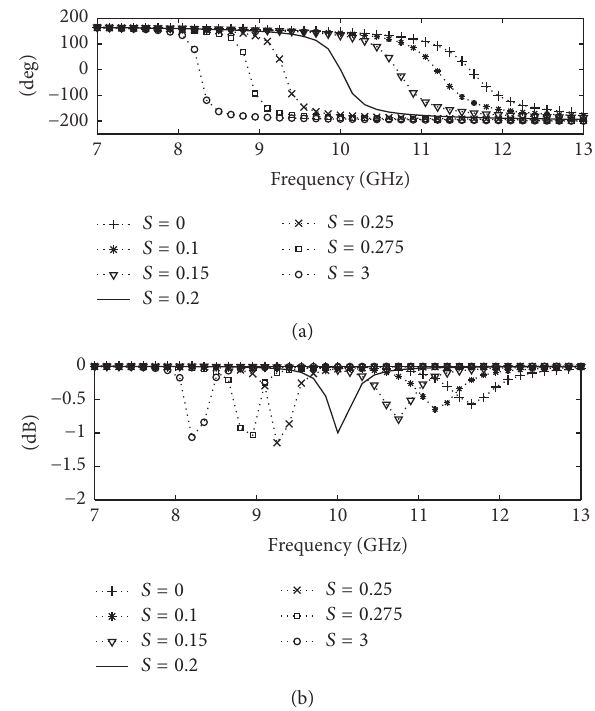
Figure 10: (a) Phase and (b) amplitude of the simulated reflection coefficient versus frequency for different value of the scaling factor 𝑆 (1st iteration fractal unit cell with 𝐿 = 7.86 mm and Δ𝑥 × Δ𝑦 = × 0.5𝜆 0.5𝜆 0 0 ).